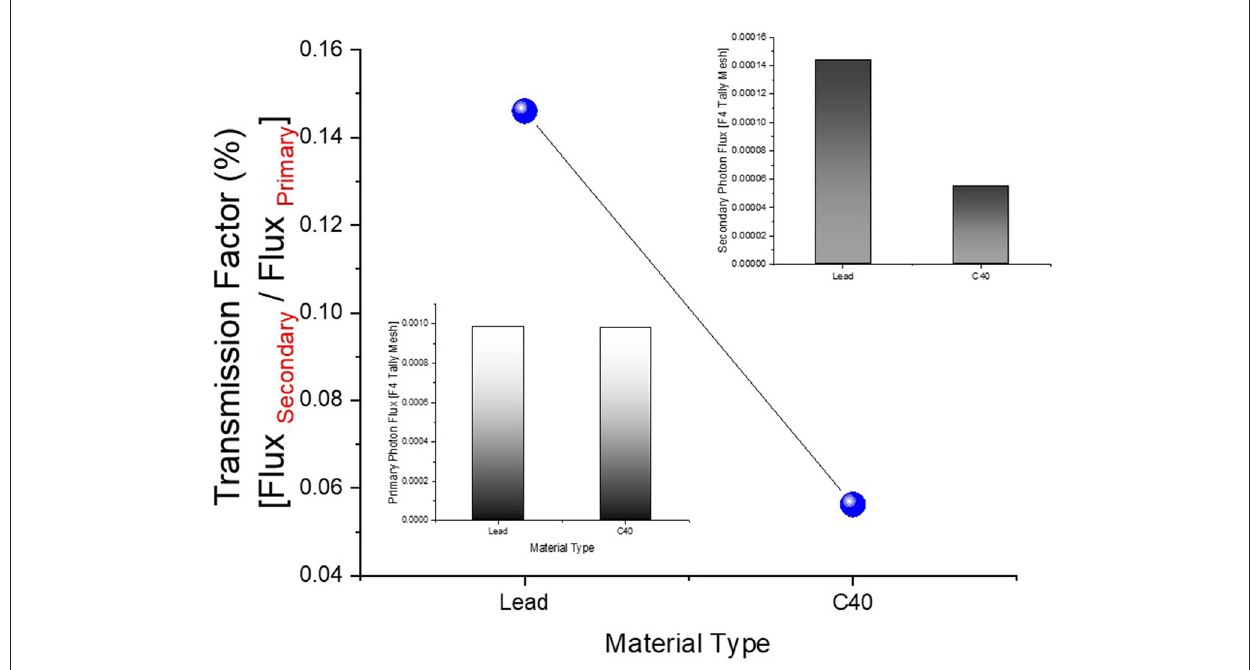
FIGURE9 Variation of TF values for Lead-Acrylic and C40 shielding screens.